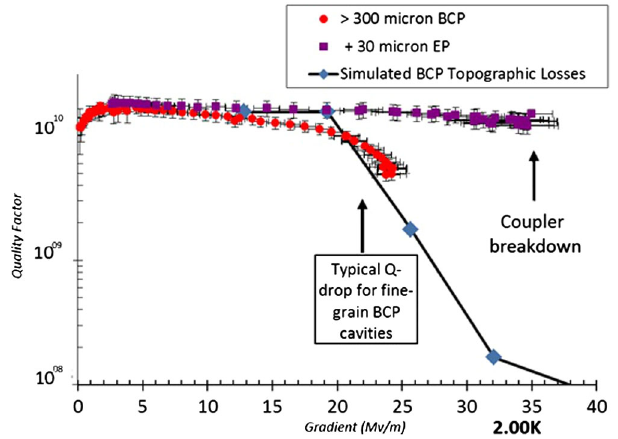
FIG. 19. Comparison of model-predicted Q 0 having represen- tative BCP surface topography with experimental data for CEBAF prototype cavity LL002 having heavily BCP etched and subsequent electropolished surfaces. No evidence of field emission loading was observed in either